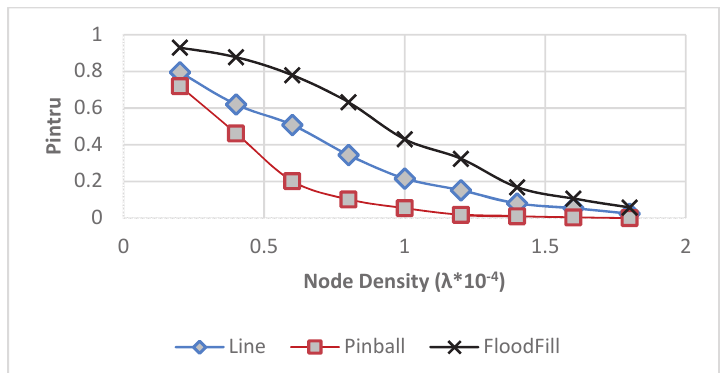
Figure 6. The escape probability ( P intru ) of an intruder that adopts the linear, pinball and flood-fill algorithms in a WSN with varying node densities λ .